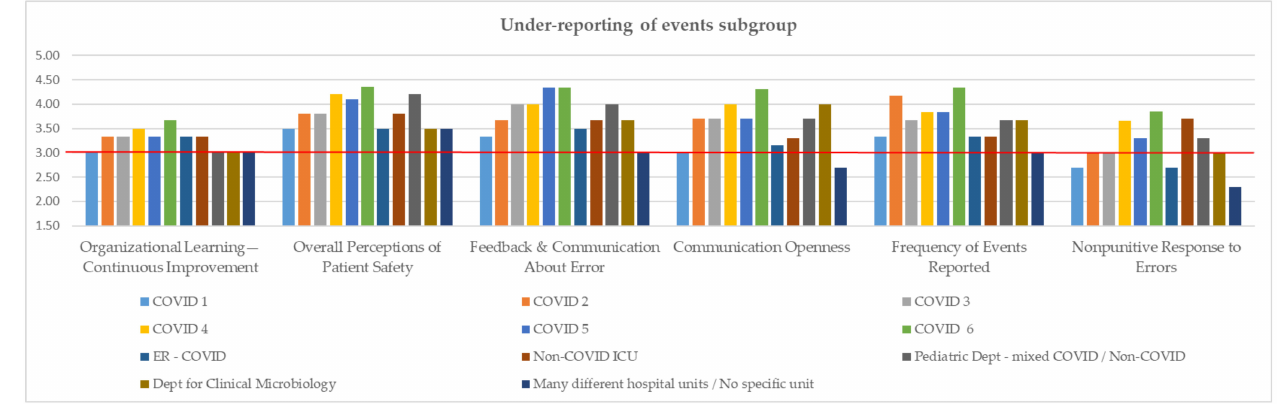
Figure 1. PSC dimension values for the “Under-reporting of events” group across departments.